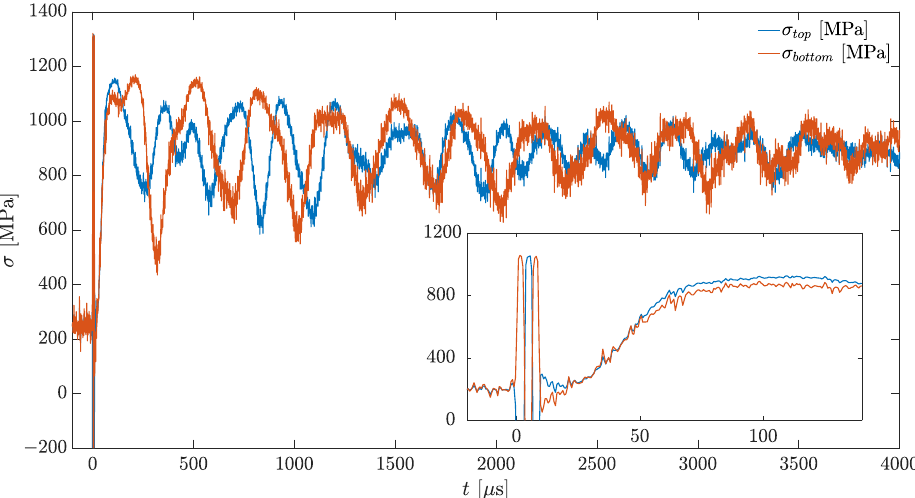
Figure 5. Typical macroscopic stress results from experiments in the clamp-clamp configuration. The onset of the electric pulse was chosen as t = 0. The curves show the measured tensile stress, in units of MPa, at each end of the SMA wire over a 4 ms time-period. The inset shows a zoom-in into the initial 100 µ